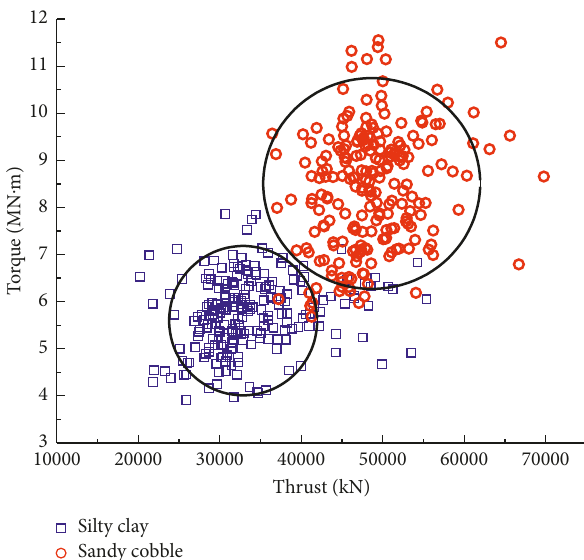
Figure 10: Scatter distribution of thrust and torque under two geological conditions.